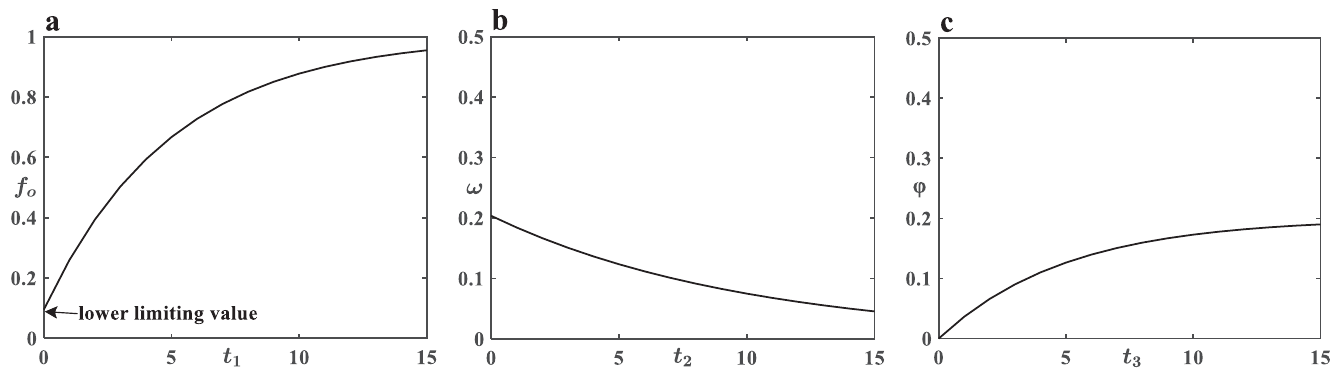
Fig 1. Descriptions of relationships between some parameters. Here θ 1 = 0.2, δ = 0.5, θ 2 = 0.2, θ 3 = 0.2. (a) The dedicator’s probability of donating ( f o ) for different break time steps ( t 1 ) when Ti < Tr has ever happened. (b) The extra cooperation probability ( ω ) for different time steps ( t 2 ) after dedicators’ donating behavior. (c) The extra defection probability ( ϕ ) for different successive times of poor performances ( t 3 ).